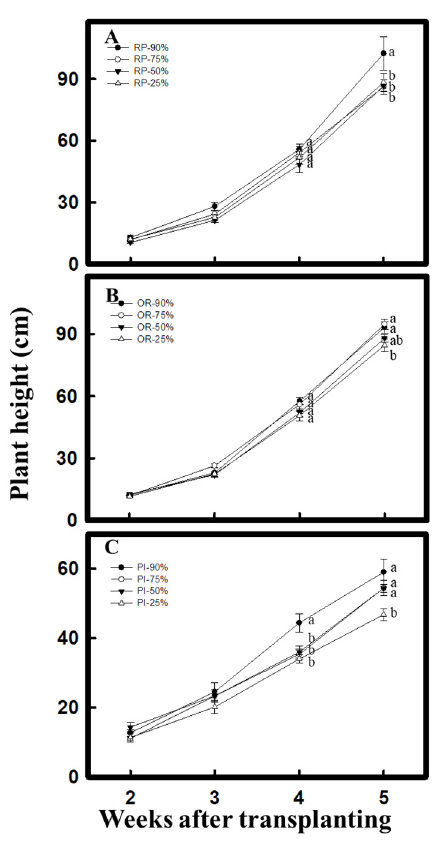
Figure 1. Effect of drought stress on plant height in C. formosana and C. quinoa during vegetative growth. From 2nd to 5th week after sowing, the plant heights of C. formosana RP variety ( A ), OR variety ( B ), and C. quinoa PI variety ( C ) were investigated. Bars show means ± SE. Values with the same letter are not significantly different by LSD ( p < 0.05, n = 5).